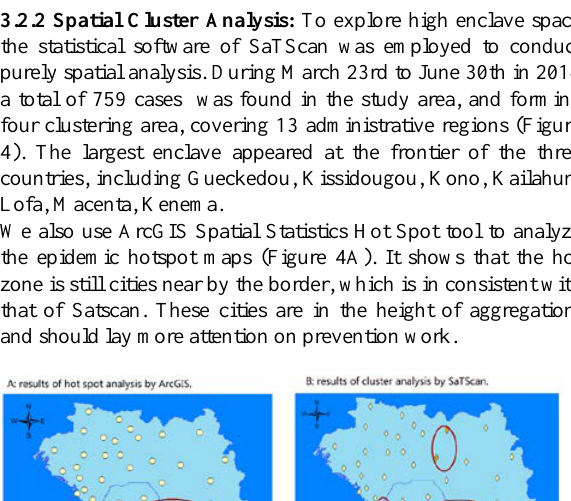
Figure 3. The spatial distribution of global EVD from March to June 2014.